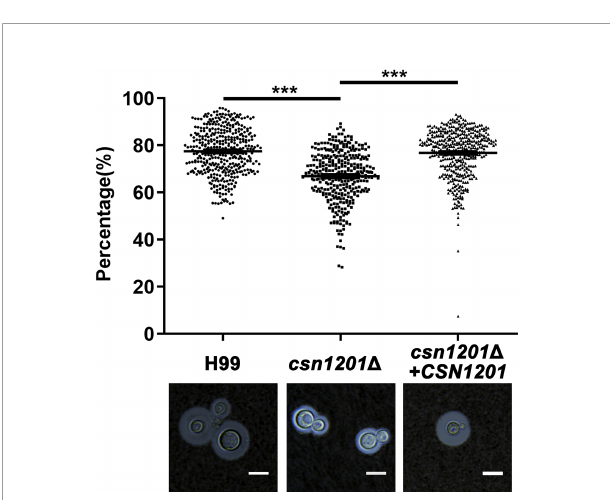
FIGURE 2 | The CSN1201 deletion down-regulates capsule production. Each strain was cultured on DME medium for capsule production at 37°C in a 5% CO 2 atmosphere for 3 days. The capsule was detected by staining with India ink and visualising at 100× magni fi cation (scale bar = 10 µm). Total (cell and capsule) and cell-only diameters were measured using Photoshop Software for at least 300 cells for each strain. ***, P < 0.001.